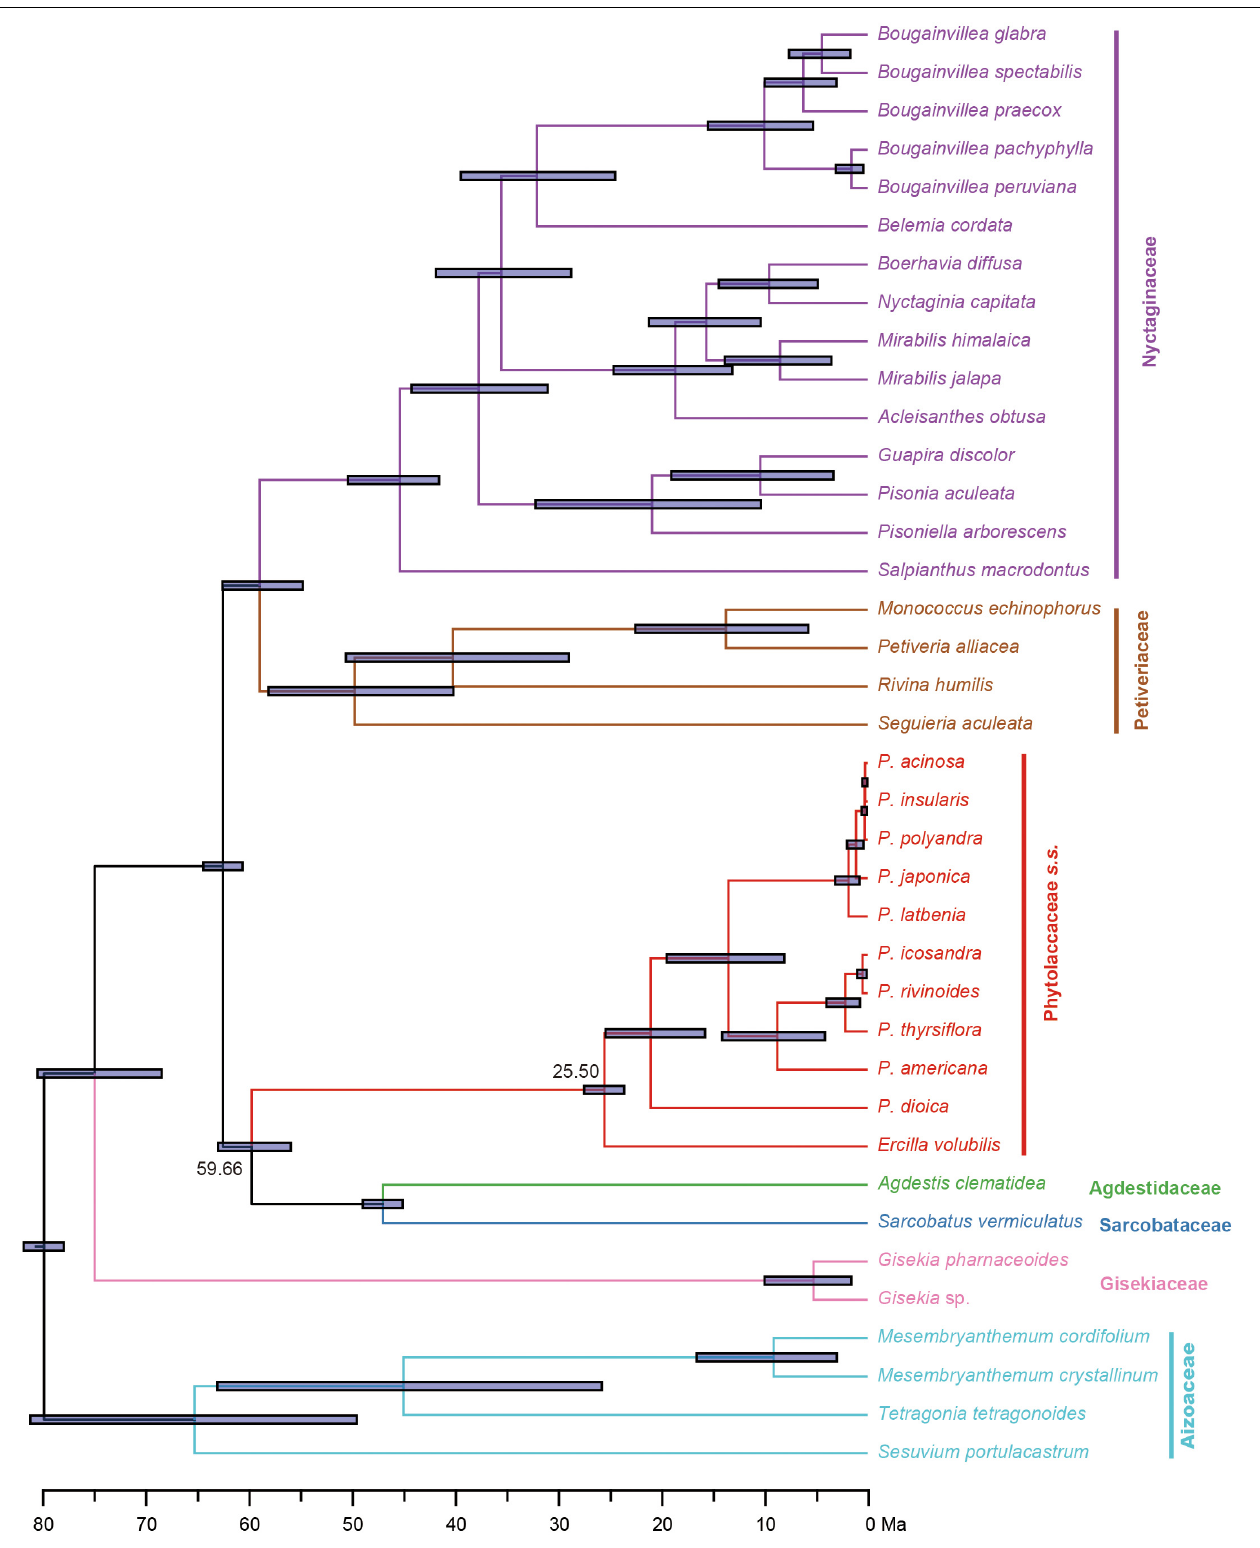
FIGURE 3 | Divergence times of Phytolaccaceae s.l. and its allies obtained from BEAST analysis based on the 83g48s dataset. The mean divergence time of the nodes is shown next to the nodes, while the blue bars correspond to the 95% highest posterior density (HPD). Black circles indicate the five calibration points.